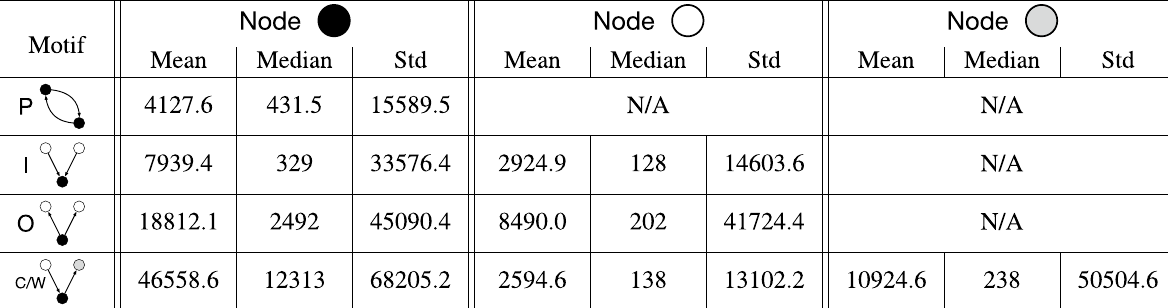
Table 3. Size of the company for each node in the static opposition motifs. We show the mean, median, and standard deviation of the number of patents owned by the companies for each node in a given type of motif. Although the order of the events is irrelevant in static motifs, we use the same notations as those for the temporal motifs for easing the comparison with Table 2. In static motifs there is no repetition (therefore, no presence of R in this table), and convey and weakly-connected are the same. It should also be noted that we do not distinguish the two nodes in the ping-pong motif because of the absence of the timing